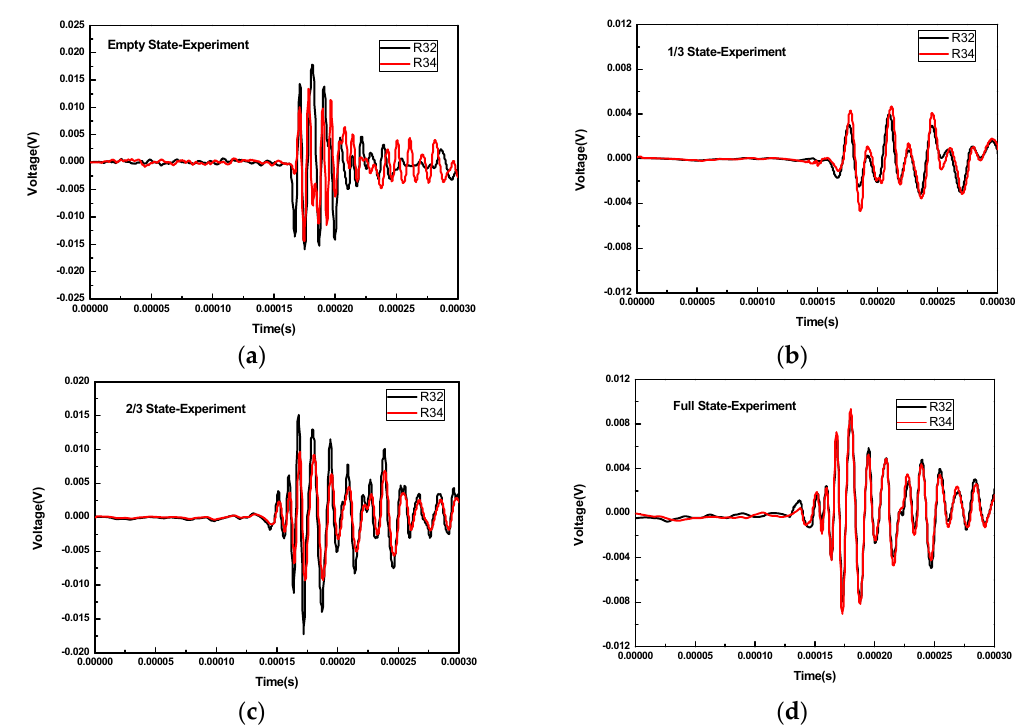
Figure 8. The waveforms received by R2 and R4 for different concrete infill conditions when R3 is used as transmitter: ( a ) the empty concrete infill; ( b ) the 1/3 concrete infill; ( c ) the 2/3 concrete infill; ( d ) the full concrete infill.